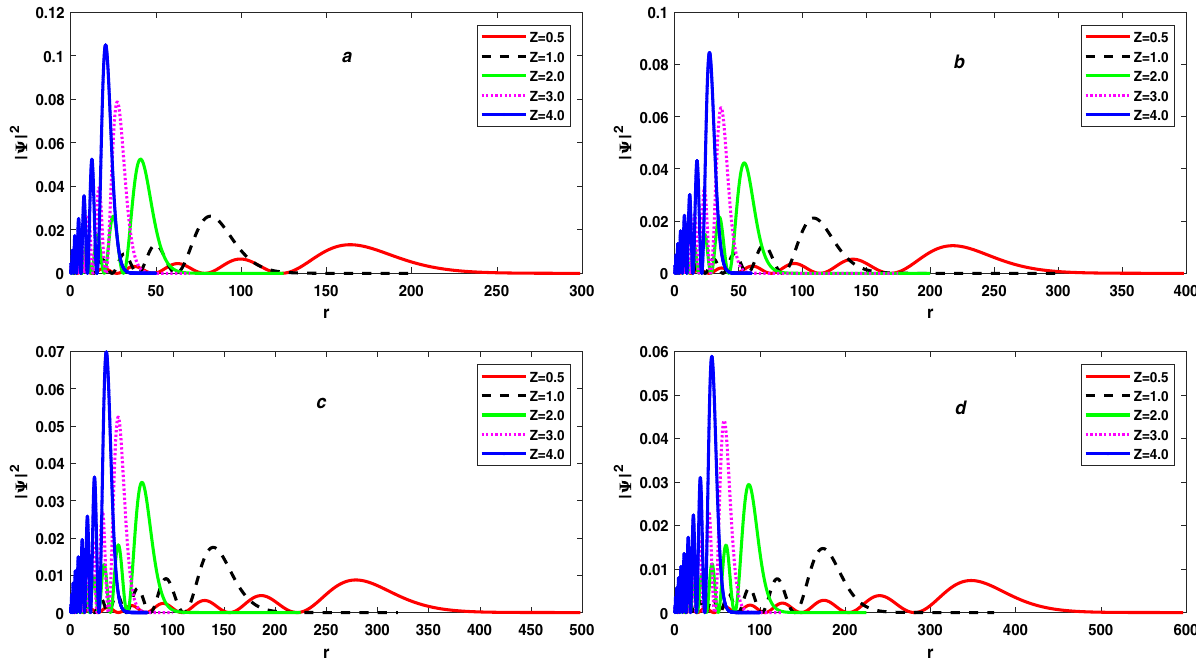
2 with r and atomic number Z for 7s state ( a ), 8s state ( b ), 9s